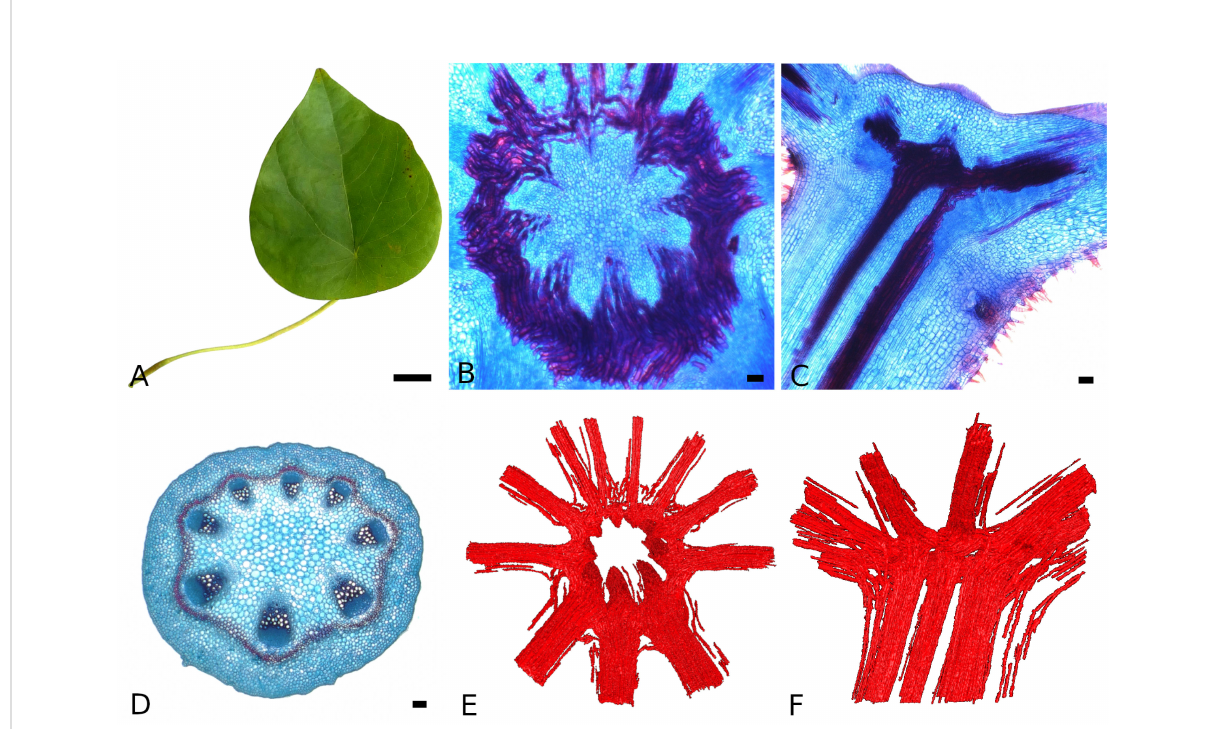
FIGURE 4 Morphology and anatomy of the Stephania japonica leaf. General leaf shape (A) , transverse (B) and longitudinal section (C) of the petiole-lamina transition zone, transverse section of the petiole (D) and topview (E) and sideview (F) of the fi ber segmentation from CT data in the transition zone. (for B , D , E : abaxial side at the bottom, staining: astrablue/safranin, scales: 2 cm (A) and 100 µm (B – D)